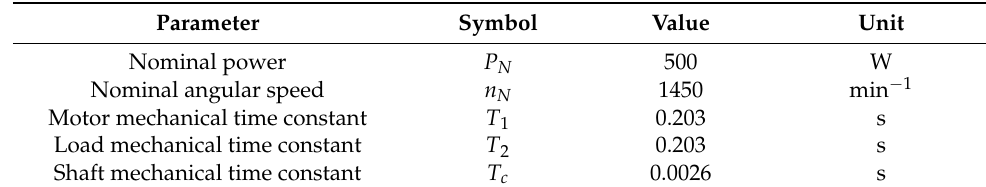
Table 1. The parameters of the electrical drive with an elastic connection.